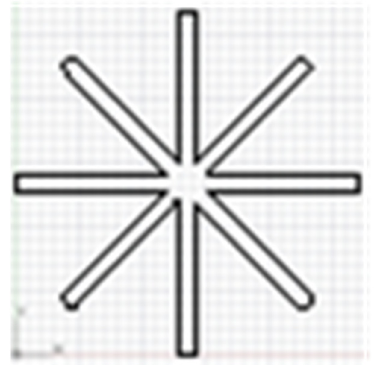
Figure 9. Idealized spatial entity Star8 (AutoCAD drawing, Autodesk AutoCAD).